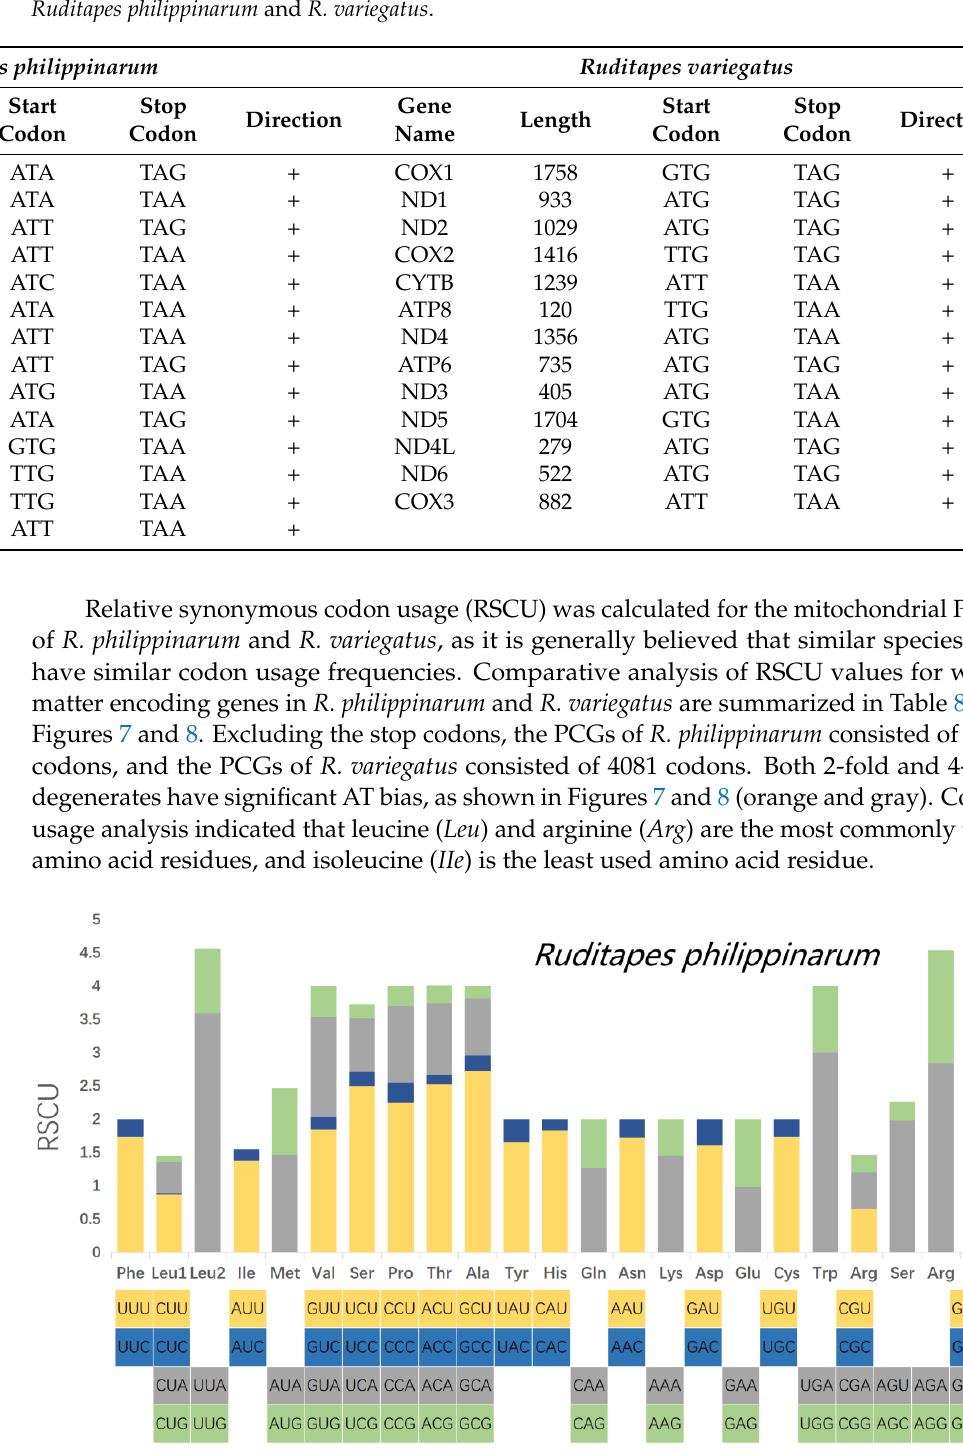
Table 7. Genomic organization and expression profile of the mitochondrial protein-coding genes in